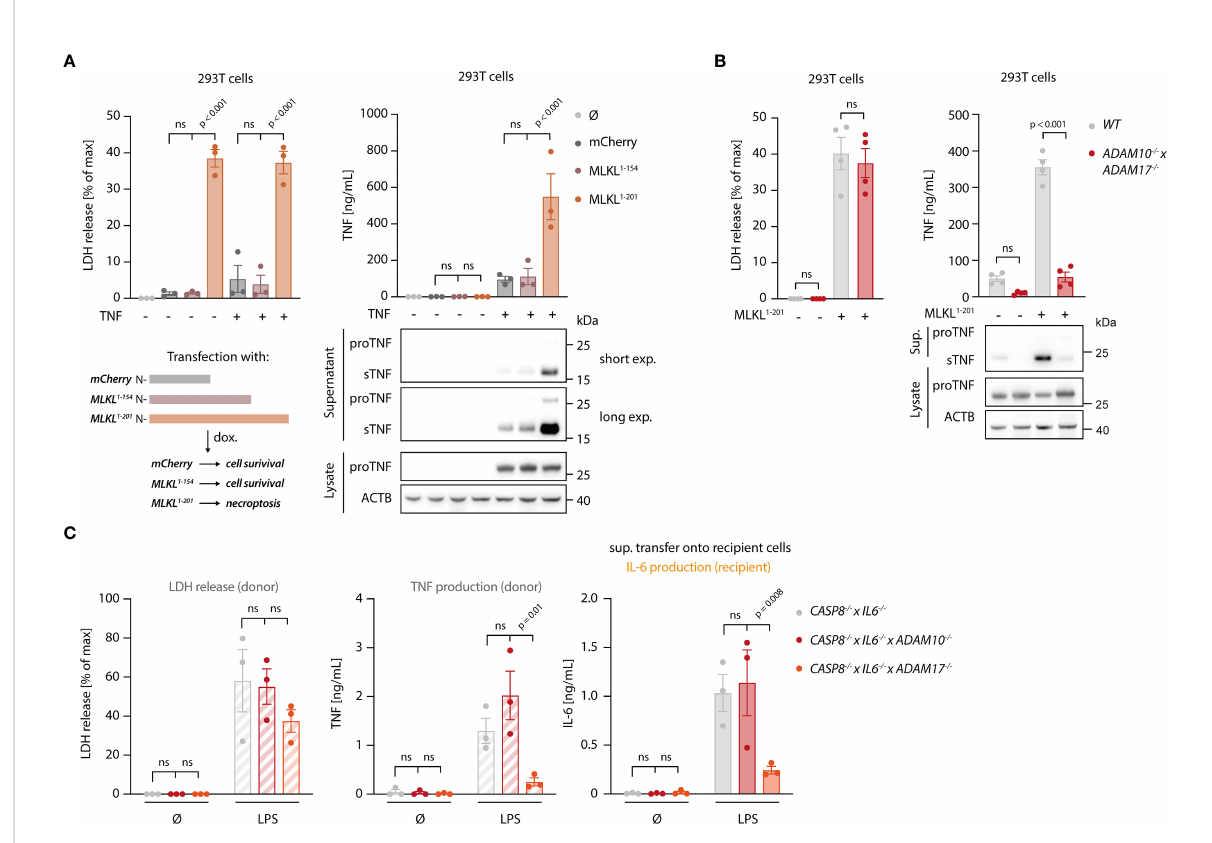
FIGURE 4 Necroptosis drives ADAM-dependent TNF shedding. (A) LDH release, TNF secretion and immunoblotting of the indicated proteins of 293T cells transfected with the speci fi ed MLKL constructs in combination with pRP-TNF (or pRP-mCherry) and stimulated the day after with doxycycline for 7 h (B) 293T cells of the indicated genotypes were transfected with pRP-TNF and pLI-MLKL 1-201 (or pLI-mCherry). LDH and TNF secretion were then determined. (C) BLaER1 cells of the indicated genotypes were stimulated with 2 ng/ml LPS or left untreated for 18 h The supernatant of these cells was utilized to stimulate TLR4 -/- BLaER1 cells. For the control supernatant of CASP8 -/- x IL6 -/- cells, the same sets of data are shown as in Figure 2H. LDH and TNF secretion from donor cells and IL-6 release by TLR4 -/- cells were measured. Data are depicted as mean ± SEM of three (A, C) or four (B) independent experiments or as one representative immunoblot of three (A, B) independent experiments. Statistics indicate signi fi cance by two-way ANOVA with a Dunnett (A, C) or S ̌ ida ́ k (B) correction for multiple testing. P values as indicated or ns, not signi fi